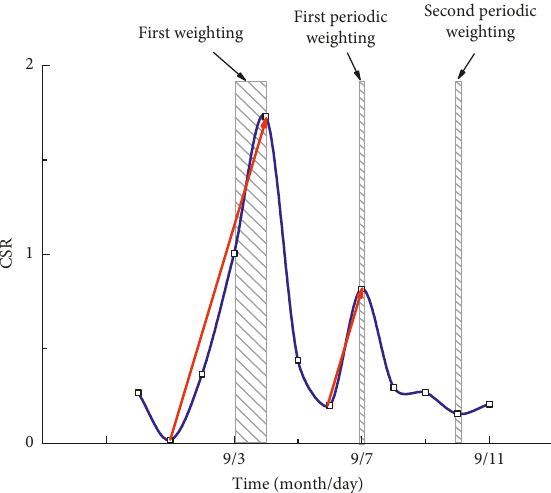
Figure 14: Changes of CSR with